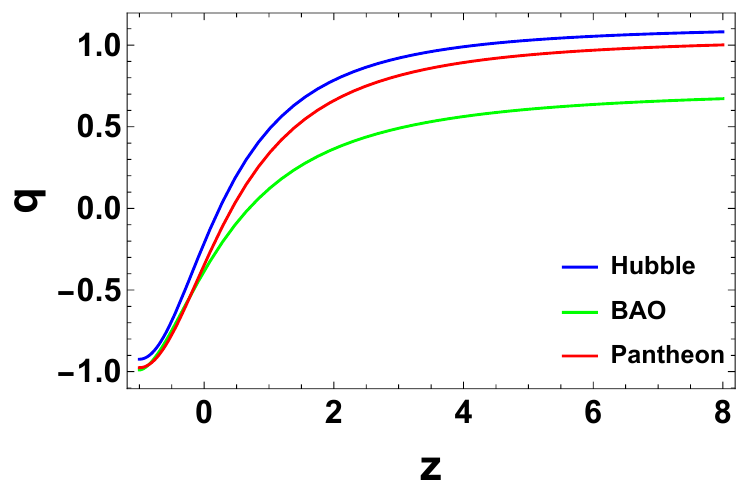
Figure 4. Profile of the deceleration parameter for the given model corresponding to the values of the parameters constrained by the Hubble, BAO, and Pantheon data point sets.